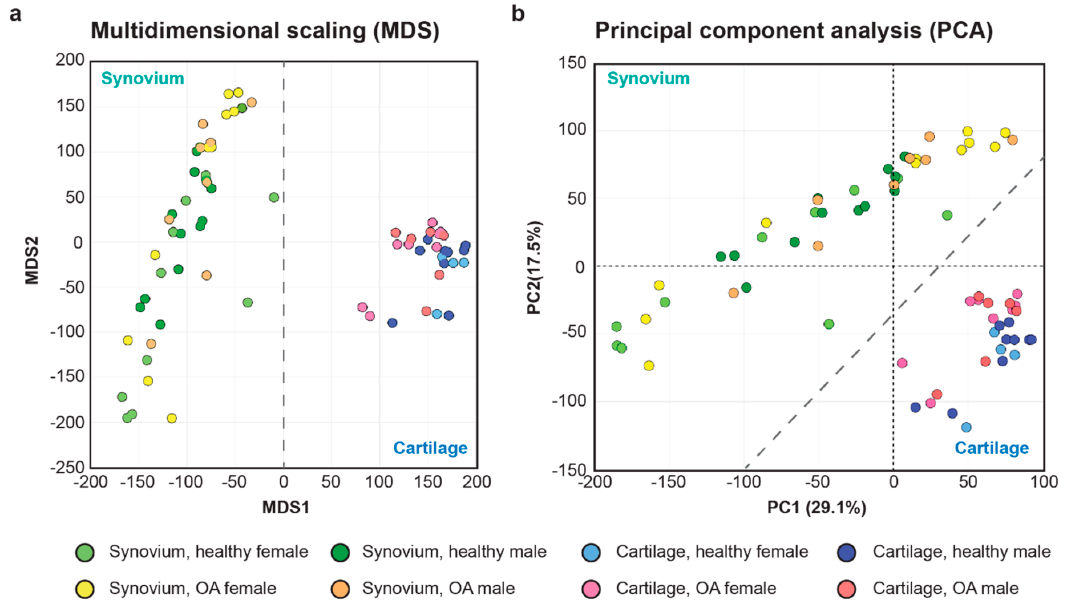
Figure 1. Multidimensional scaling (MDS) ( a ) and principal component analysis (PCA) ( b ) distinguish transcriptome of synovium and cartilage samples included in the current study.